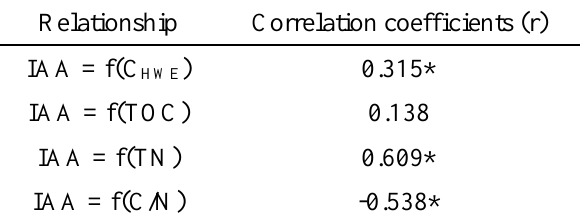
Table 5. Correlation coefficients of the relationships between IAA content and other investigated factors in different peat-forming species (*significance level water extractable organic carbon, TOC = total organic carbon, TN = total nitrogen, C/N = C/N